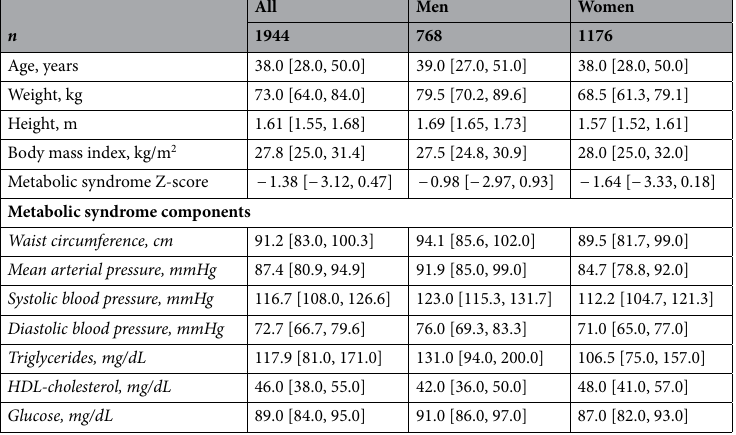
Table 1. Characteristics of the subjects. Data are frequency, or median [25th percentile, 75th percentile].